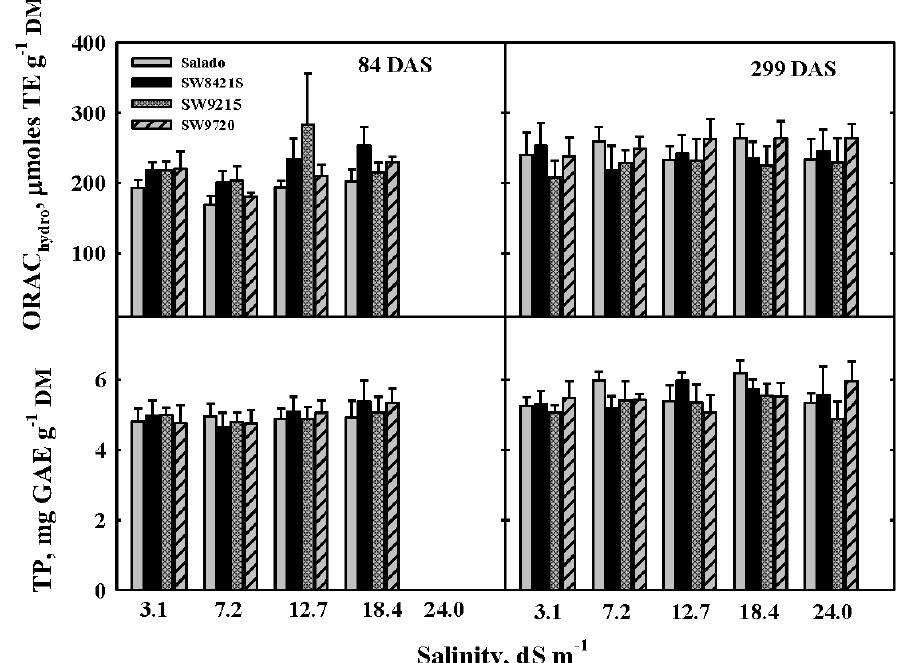
Figure 2. Total phenolics (TP) and hydrophilic shoot oxygen radical absorbance capacity (ORAC) of four salinity-tolerant alfalfa cultivars irrigated with saline water with different electrical conductivity levels. ORAC was measured in micromoles of trolox equivalents per gram of dry matter ( μ moles·TE·g − 1 DM). TP was measured as mg of gallic acid equivalents per gram of dry matter (mg·GAE·g − 1 DM). Bars represent means (±SD), where n = 4. Plants were sampled at 84 and 299 days after sowing. For the harvest at 84 DAS, the lack of data at 24 dS·m − 1 was due to growth